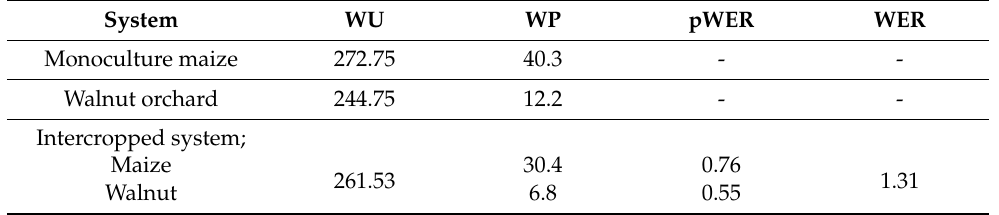
Table 5. Water use (WU [mm]), water productivity (WP [kg/ha/mm]), and water equivalent ratio (WER).